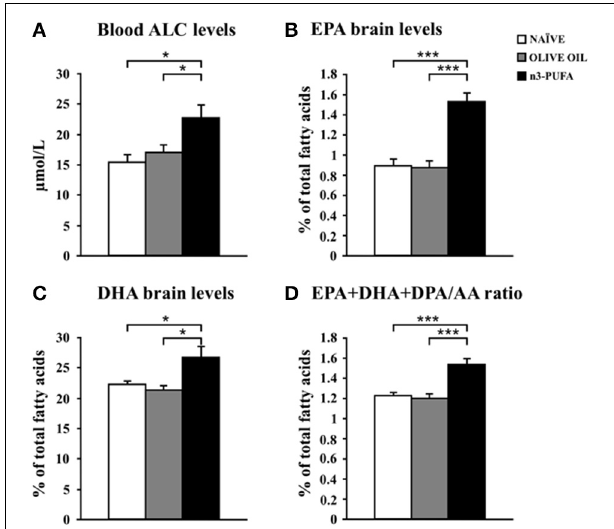
FIGURE 6 | n-3 PUFA effects on metabolic correlates. (A) Average blood levels of acetylcarnitine (ALC) for the three experimental groups. (B) EPA brain levels. (C) DHA brain levels. (D) EPA+DHA+DPA/AA ratio. ∗ p < 0 . 05, or ∗∗∗ p < 0 .